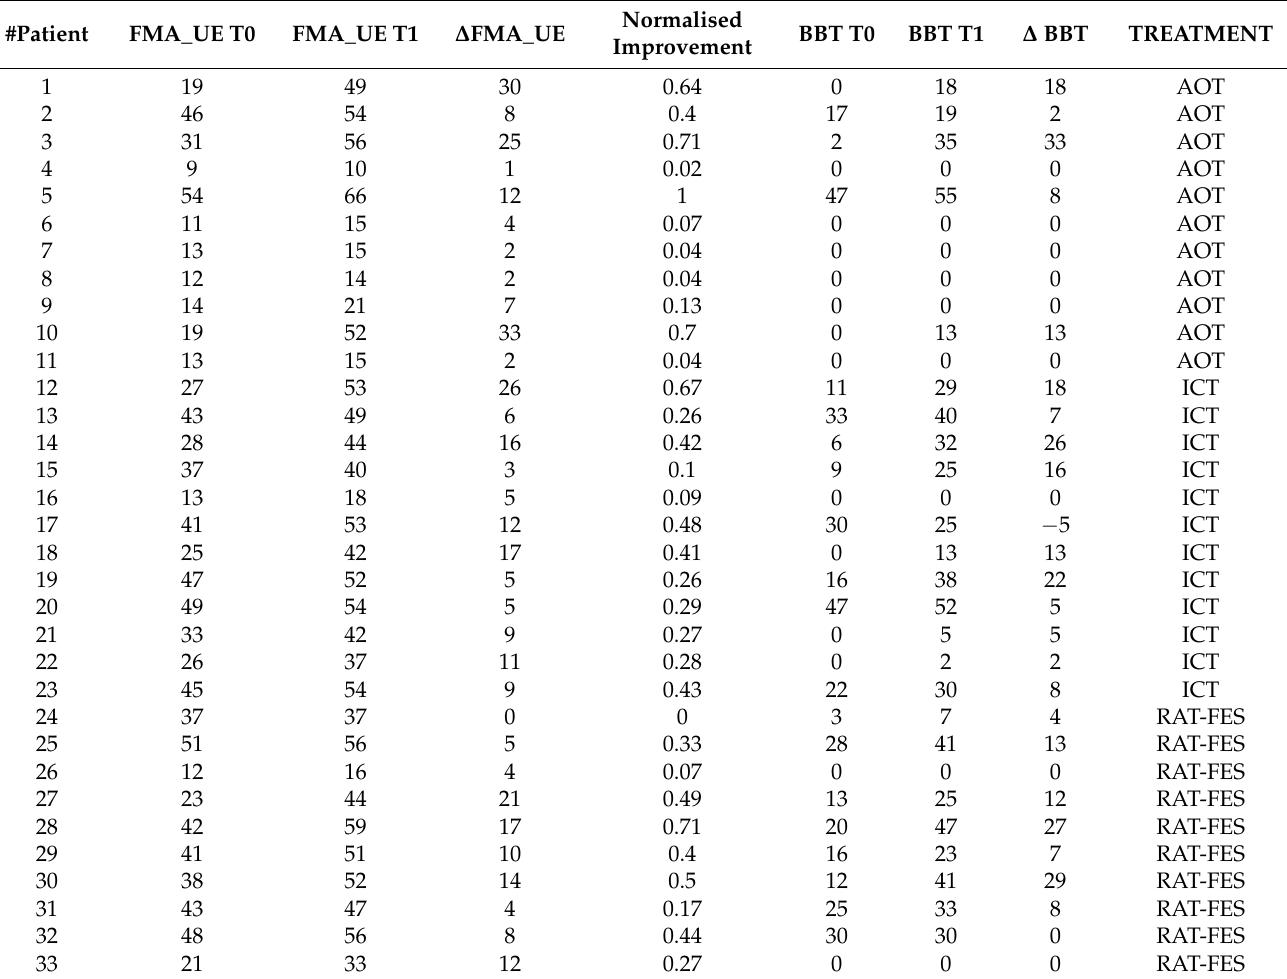
Table 2. FMA_UE and BBT at T0 and T1 and variation ( ∆ FMA_UE and normalised improvement for the FMA_UE) from T0 to T1 in each